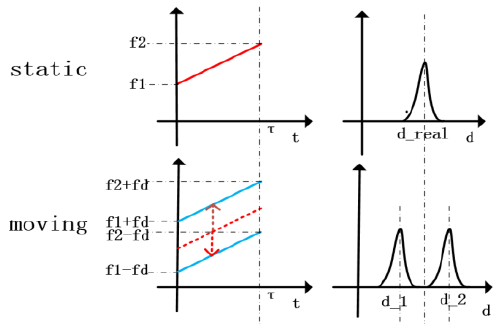
Figure 2 . The principle of distance and velocity measurement.